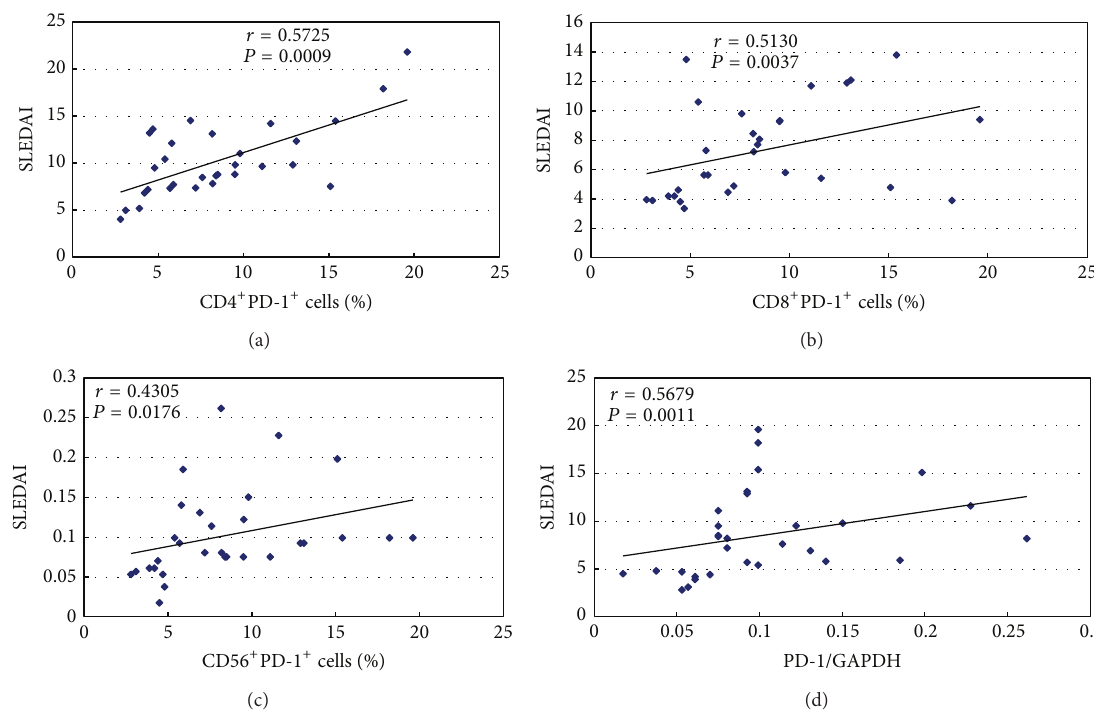
Figure 2: Correlation of upregulated PD-1 expression levels with SLEDAI in PBMCs. The association of SLEDAI with upregulated PD-1 expression on CD4 + T cell (a), CD8 + T cell (b), CD56 + T cell (c), and mRNA expression of PD-1 in PBMCs (d).